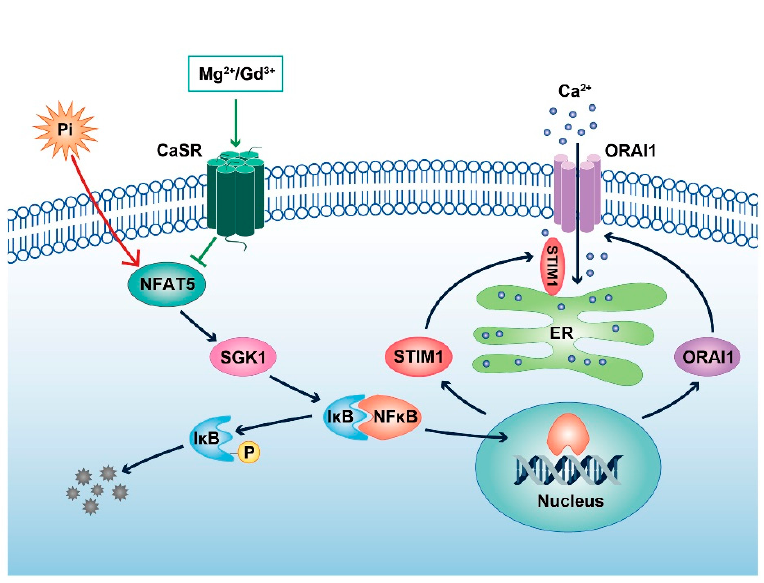
Figure 7. Mg 2+ and Gd 3+ interfere with phosphate-induced SOCE upregulation by the activation of CaSR in megakaryocytes—a schematic representation. In megakaryocytes, the phosphate donor ß-glycerophosphate upregulates NFAT5 and SGK1 expression, which leads to the degradation of the NF κ B inhibitory protein I κ B with subsequent nuclear translocation of NF κ B and NF κ B-dependent transcription of ORAI1 and STIM1. CaSR can be activated by cations such as Mg 2+ and Gd 3+ and inhibits phosphate-induced SOCE enhancement, at least partially, via the downregulation of the signaling pathway. CaSR, calcium-sensing receptor; ER, endoplasmic reticulum.